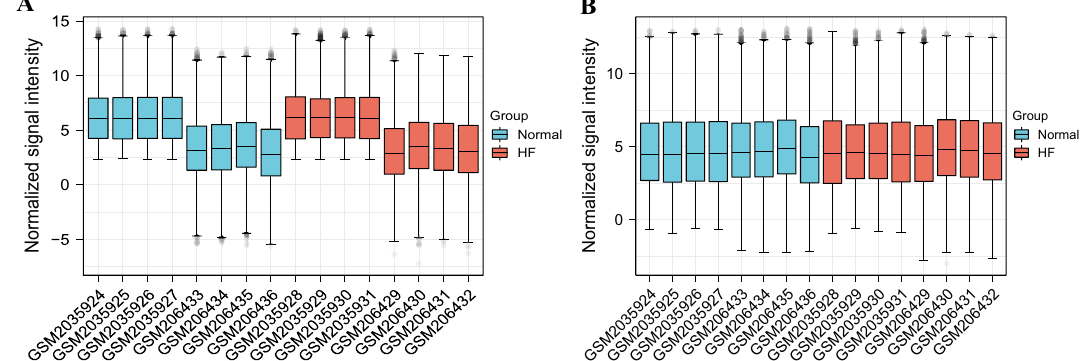
Figure 1. Boxplots of gene expressions before and after standardization for 2 selected GEO Database. (( A ) Before standardization; ( B ) After standardization. Normal: Normal Group; HF: Heart Failure